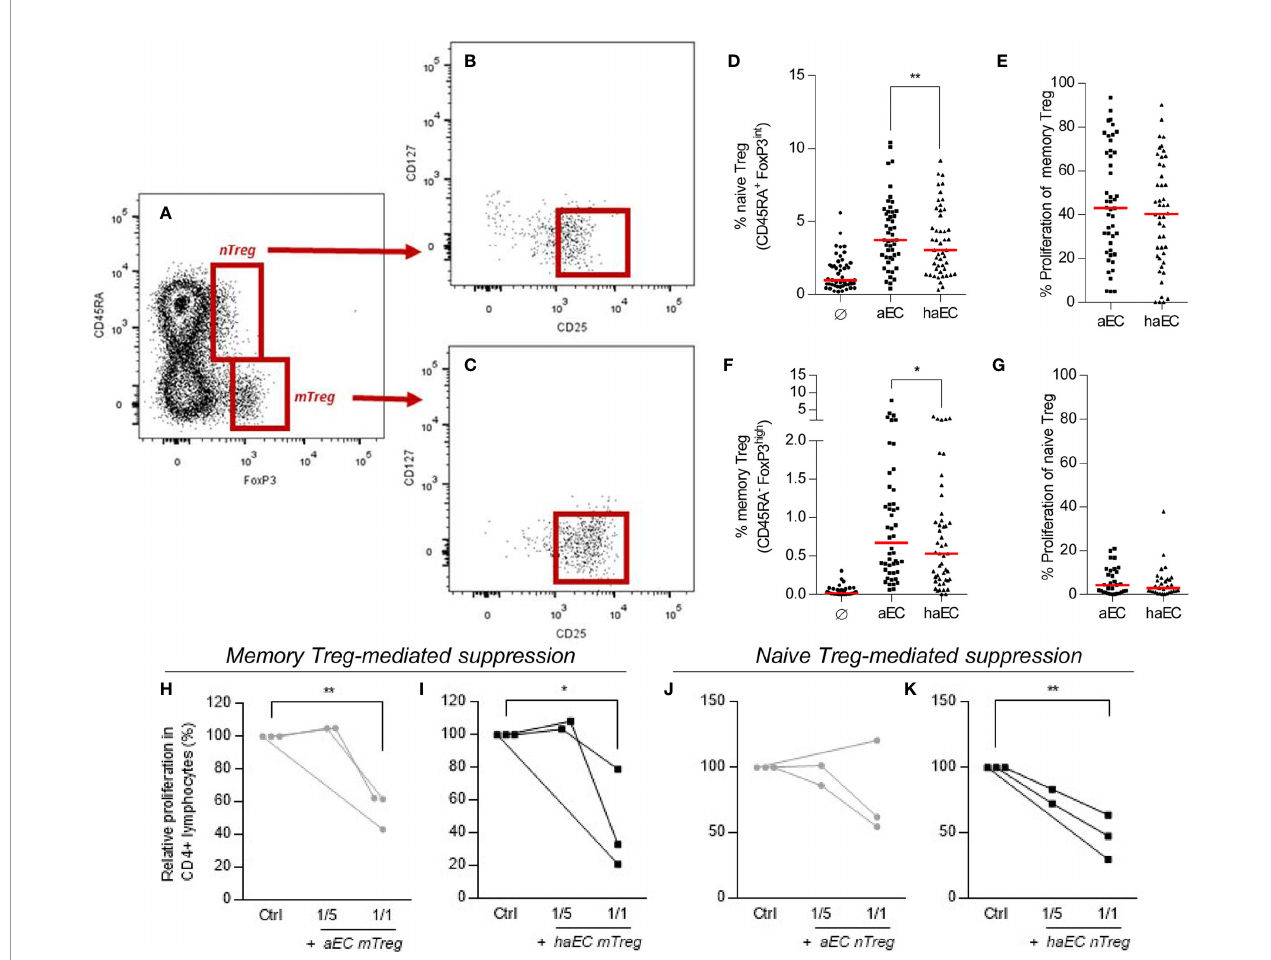
FIGURE 2 | Human microvascular endothelial cells increase the fraction of naïve and memory regulatory subsets in CD4 + T lymphocytes. PBMC were cultured in the absence of endothelial cells (Ø), in the presence of activated endothelial cells (aEC) or highly activated endothelial cells (haEC). Naïve Treg were de fi ned as CD4 + CD45RA + FoxP3 + (A) ; these cells were mostly CD127 - CD25 + (B) . Memory Treg were de fi ned as CD4 + CD45RA - FoxP3 ++ (A) ; these cells were mostly CD127 - CD25 ++ (C) . The expansion of naïve and memory Treg subsets was assessed (D, F) , in addition to their respective proliferation during culture (E, G) (n = 48; red lines represent the median; Wilcoxon test). Memory and naïve Treg subsets were evaluated for their capacity to suppress the proliferation of responder CD4 + T lymphocytes. Memory and Naïve Treg (mTreg and nTreg) were isolated from 7-day cocultures with either activated or highly activated endothelial cells (aEC or haEC). Treg subsets were isolated by sorting from PBMC, then cultured with autologous responder CD4 + T lymphocytes and CD3/CD28 Dynabeads at a ratio of 1 or 5 responder CD4 + T cells per bead. The proportion of responders having undergone three divisions is represented as a percentage of the maximum proliferation in the absence of Treg cells. Memory Treg (mTreg) and naïve Treg (nTreg) from aEC cocultures are represented with grey lines (H – K) , whilst mTreg and nTreg from haEC cocultures are shown in black lines ( H – K ; n =3; paired